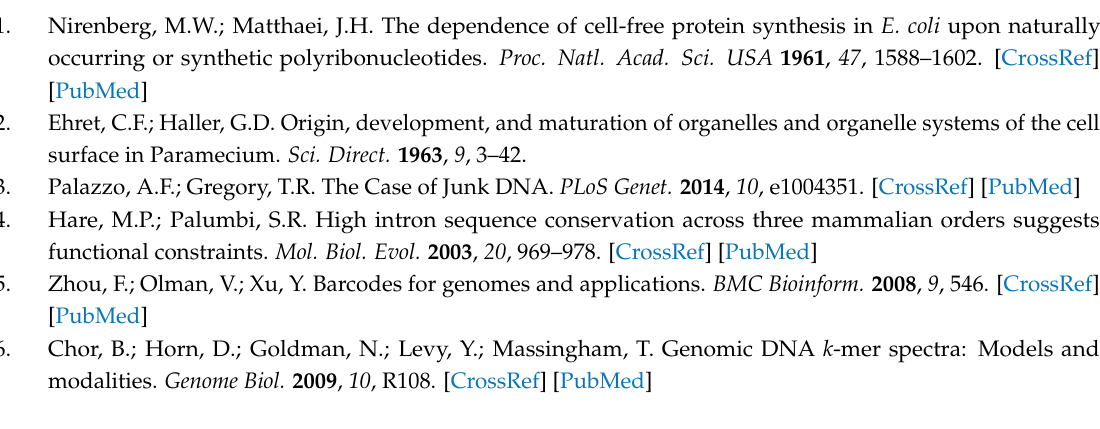
Figure S1: Heatmap of Correlations between individual intron and intergenic regions (k = 11)., Figure S2: Markov Simulation (order: zero, k=10), Figure S3: Markov Simulation (order: zero, k=7), Figure S4: Markov Simulation (order: 1, k=7), Figure S5: Markov Simulation (order: 2, k=7), Table S1: Accession numbers of sequences, Table S2: List of top 100 k-mer words with highest contribution to correlation values for k = 7, Table S3: Table S3. List of 100 k-mer words with highest contribution to correlation values for k =